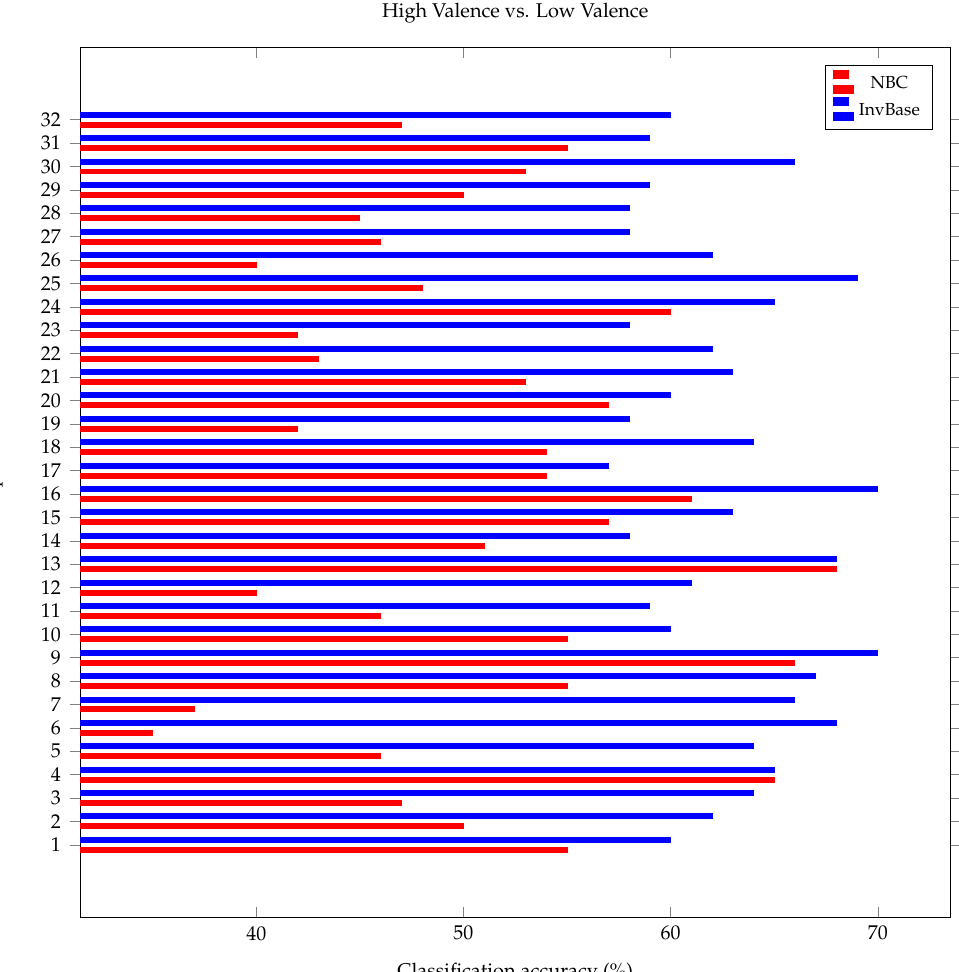
Figure 13. Comparison of valence classification accuracy using InvBase method and NBC in leave- one-out